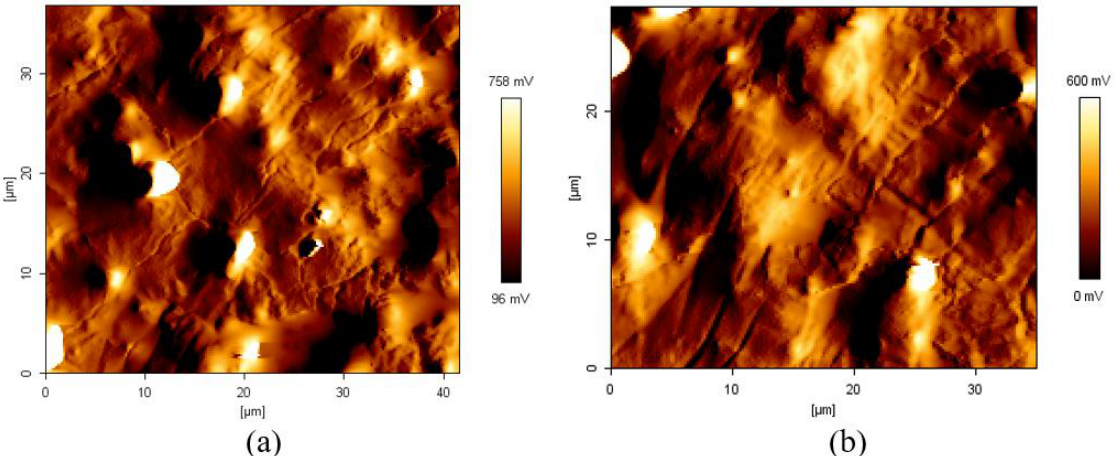
Figure 5. AFM images of the shear band deformation in the MRE matrix ( a ) during the early formation of the shear band and ( b ) after the durability evaluation, where shear band deformation with larger spacing was observed.